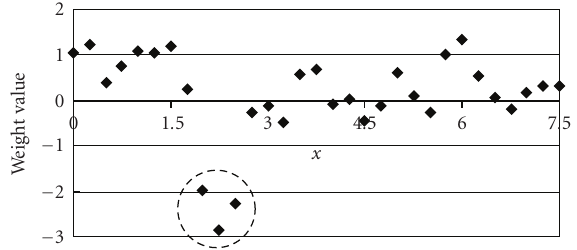
Figure 12: Connection weights to the 31st neuron from the input neurons that are responsible for the x location of the object. Lateral axis indicates the most responsible point of each input neuron. For example, the connection weight from the input neuron that takes the maximum value at x = 2 . 25 is approximately − 2 .